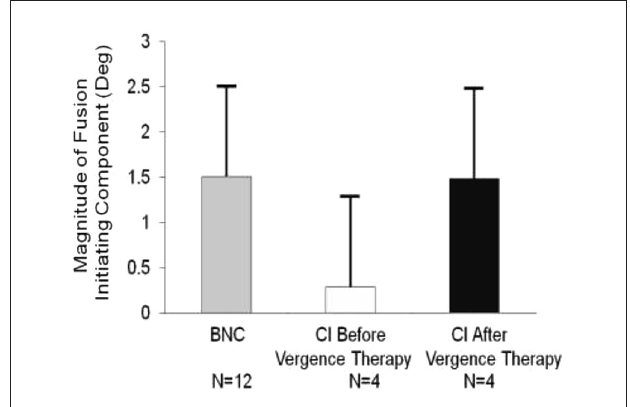
FIGURE 3 | Group analysis of the average peak magnitude of the convergence FIC for BNC (gray bar), CI subjects before vergence therapy (light gray bar), and the same CI subjects after vergence therapy (black bar). Error bars represent one standard deviation. The average convergence FIC for CI subjects before vergence therapy is significantly reduced compared to BNC and then significantly improves post vergence therapy. The number of subjects studied is denoted under each bar.